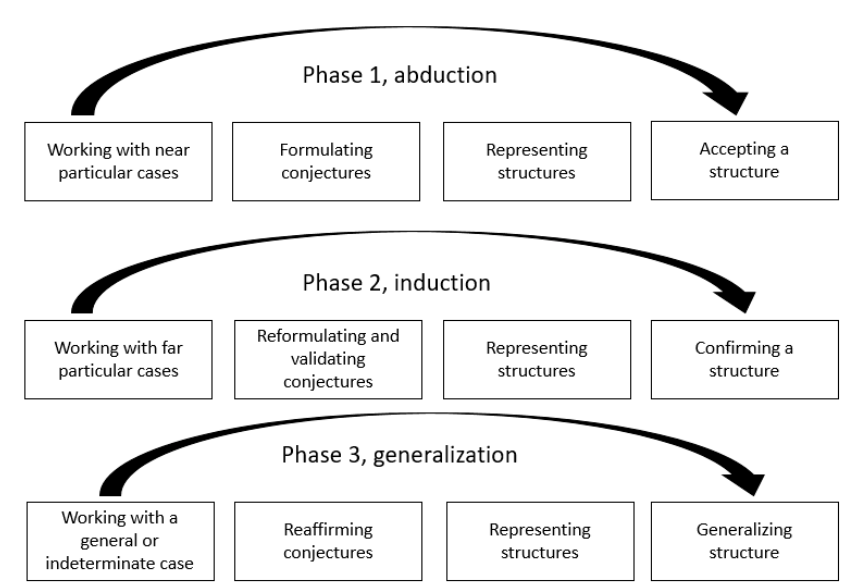
Figure 13. Adapted generalization process model.